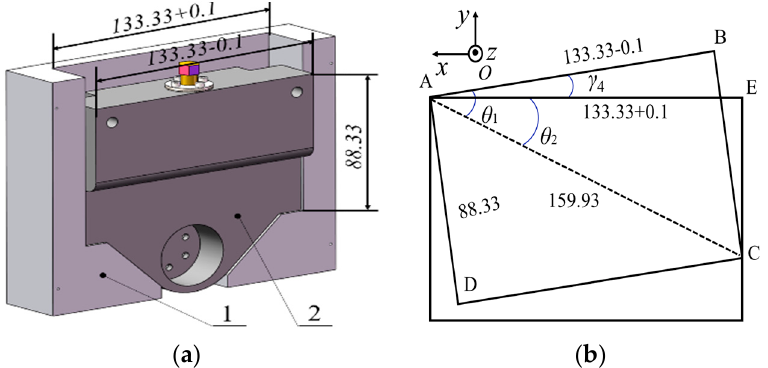
Figure 7. Assembly deviation between cutter holders and cutter box. ( a ) Dimensions of cutter holder and cutter box. 1—Cutter box, 2—Cutter holder. ( b ) The geometric model of angle deviation between cutter holder and cutter box.